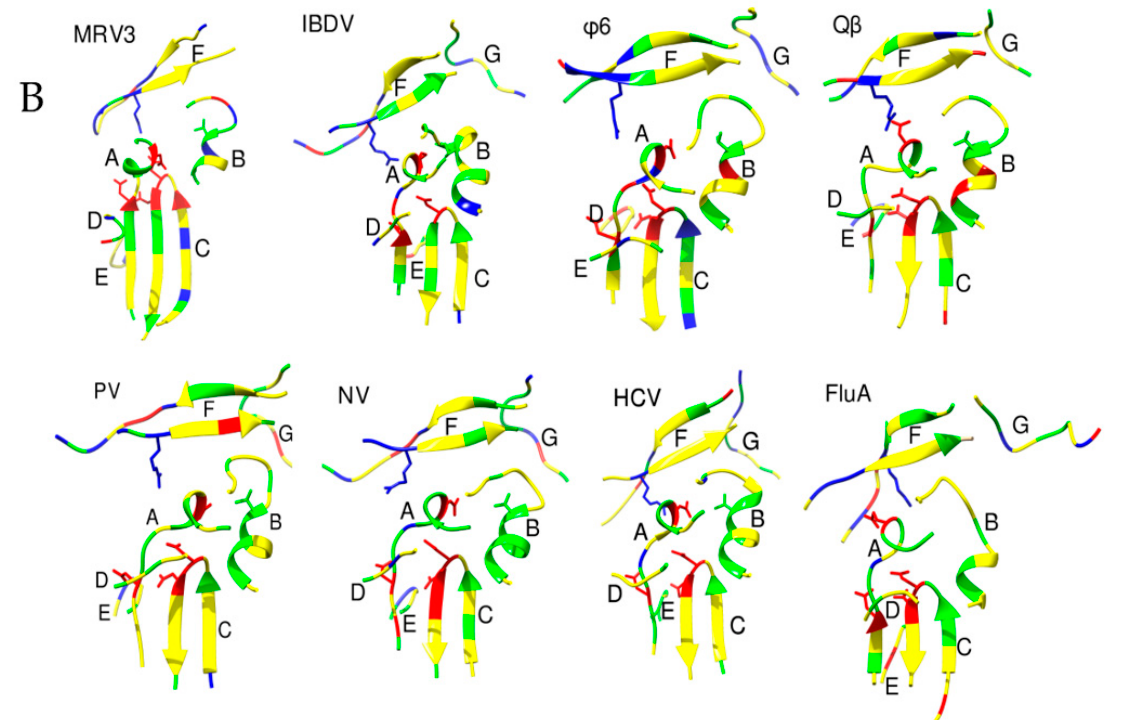
Figure 1. The architecture of RdRp. Panels A and C show the RdRps in the same orientation, viewing down the active site cleft. ( A ) RdRp of Japanese encephalitis virus (JEV) (PDB ID: 4mtp) [32] showing the thumb (Green), palm (Grey) and fingers subdomains (Blue). The linker connecting the RdRp and methyltransferase domains is depicted in purple. The components of fingers subdomains including Index (Cyan), Middle (Blue), Ring (Cornflower blue) and Pinky (Navy Blue) are indicated. The metal ions (Zn) are shown as spheres of red and a GTP that is bound at the active site is shown as sticks in orange color. The characteristic priming loop of Flaviviridae is shown in olive green that fills up the active site and facilitates de novo initiation. ( B ) The structural motifs A to F of RdRps from representative viruses of families: Reoviridae (Simian rotavirus SA11 (SiRV)), Birnaviridae ( Infectious bursal disease virus (IBDV)), Cystoviridae ( Pseudomonas phage φ 6 ( φ 6)), Orthomyxoviridae ( Influenza A virus (FluA)), Picornaviridae (Poliovirus type I (PV)), Caliciviridae (Human Norovirus (hNoV)), Flaviviridae ( Hepatitis C virus (HCV)), and Leviviridae ( Bacteriophage Q β (Q β )) are shown in ribbon representation. The polar residues are presented in green color, acidic in red and basic in blue. The conserved aspartates of motif A, threonine of motif B, and arginine of motif F are represented as sticks. ( C ) The RdRp of Coxsackievirus B3 (CVB3, PDB ID: 4zpc) [47] from Picornaviridae , shown in surface representation and colored based on electrostatic potential, reveals the NTP entry channel and the template channel. The channels are lined with positively charged residues and promote the binding of the template RNA, the primer, and NTPs for